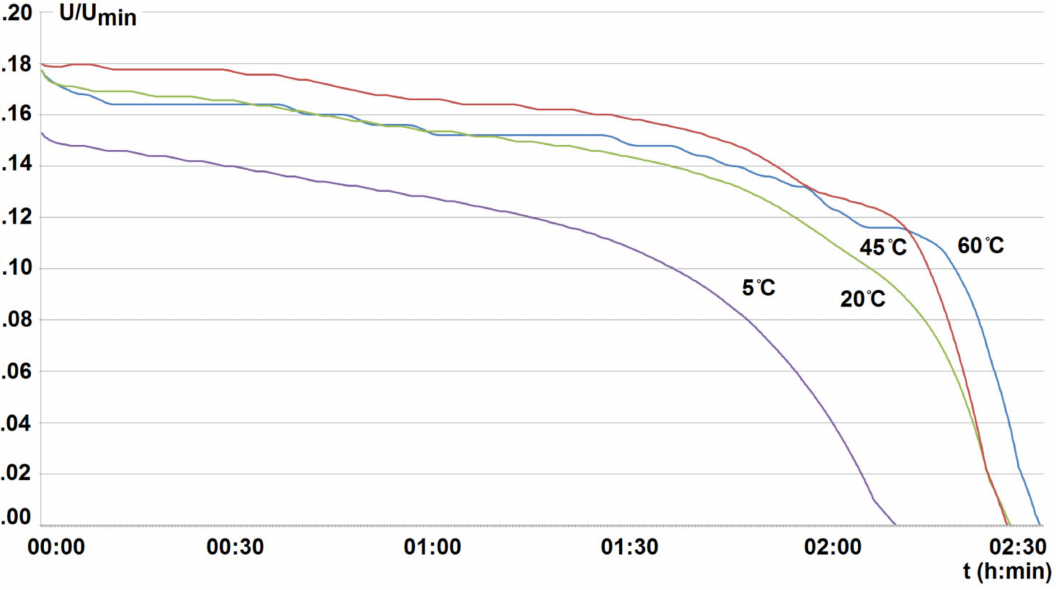
Figure 11. Time of voltage decrease to the minimum value (U min = 2.5 V) depending on the ambient temperature (+5 ÷ +60 ◦ C) at 3.8 A constant